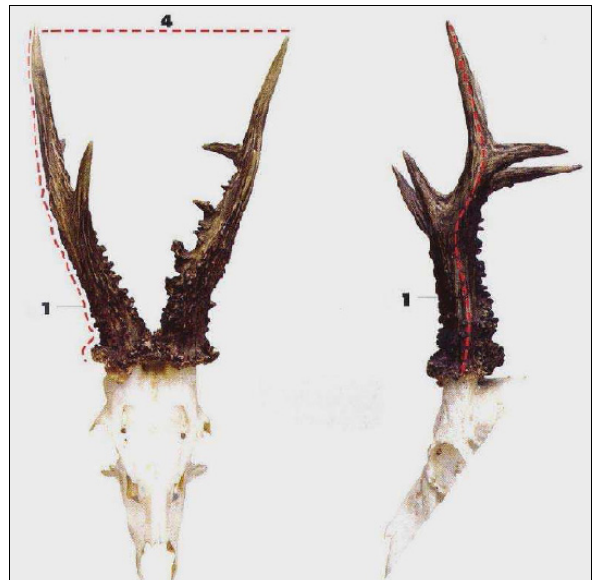
Figure 8. Antlers measuring method (“Reglamento de Funcionamiento y Manual Práctico de Andalucía”)